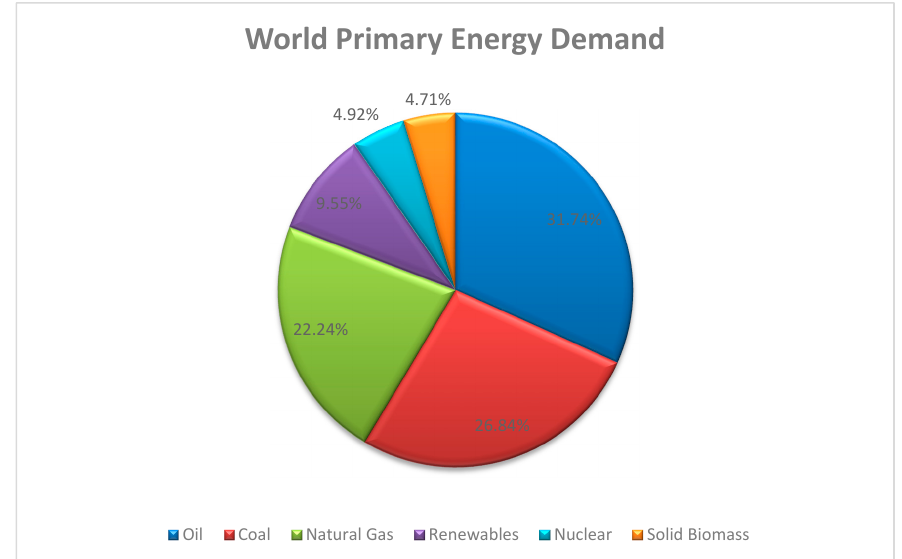
Figure 1. World primary energy demand for the year 2017.